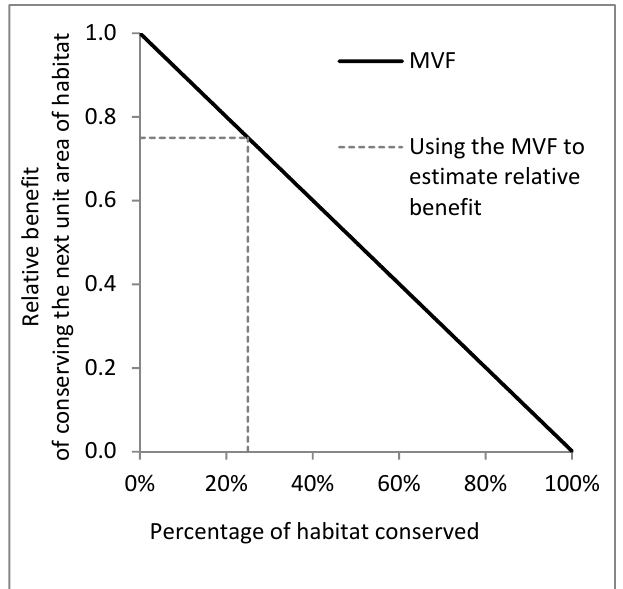
Figure 5. A simple marginal value function for determining relative benefit in a representation analysis. If an example habitat has 25% of its extent protected, and has been assigned this simple marginal value function (MVF), then the relative benefit to biodiversity of conserving the next unit area of this habitat is ¾ of what it was to conserve its first unit area.